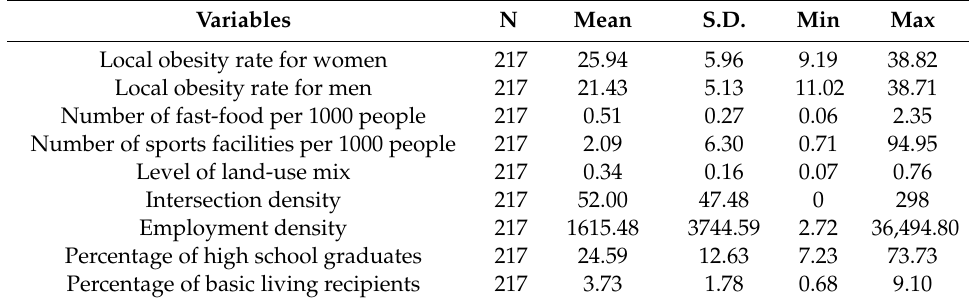
Table 1. Summary statistics of the explanatory variables.